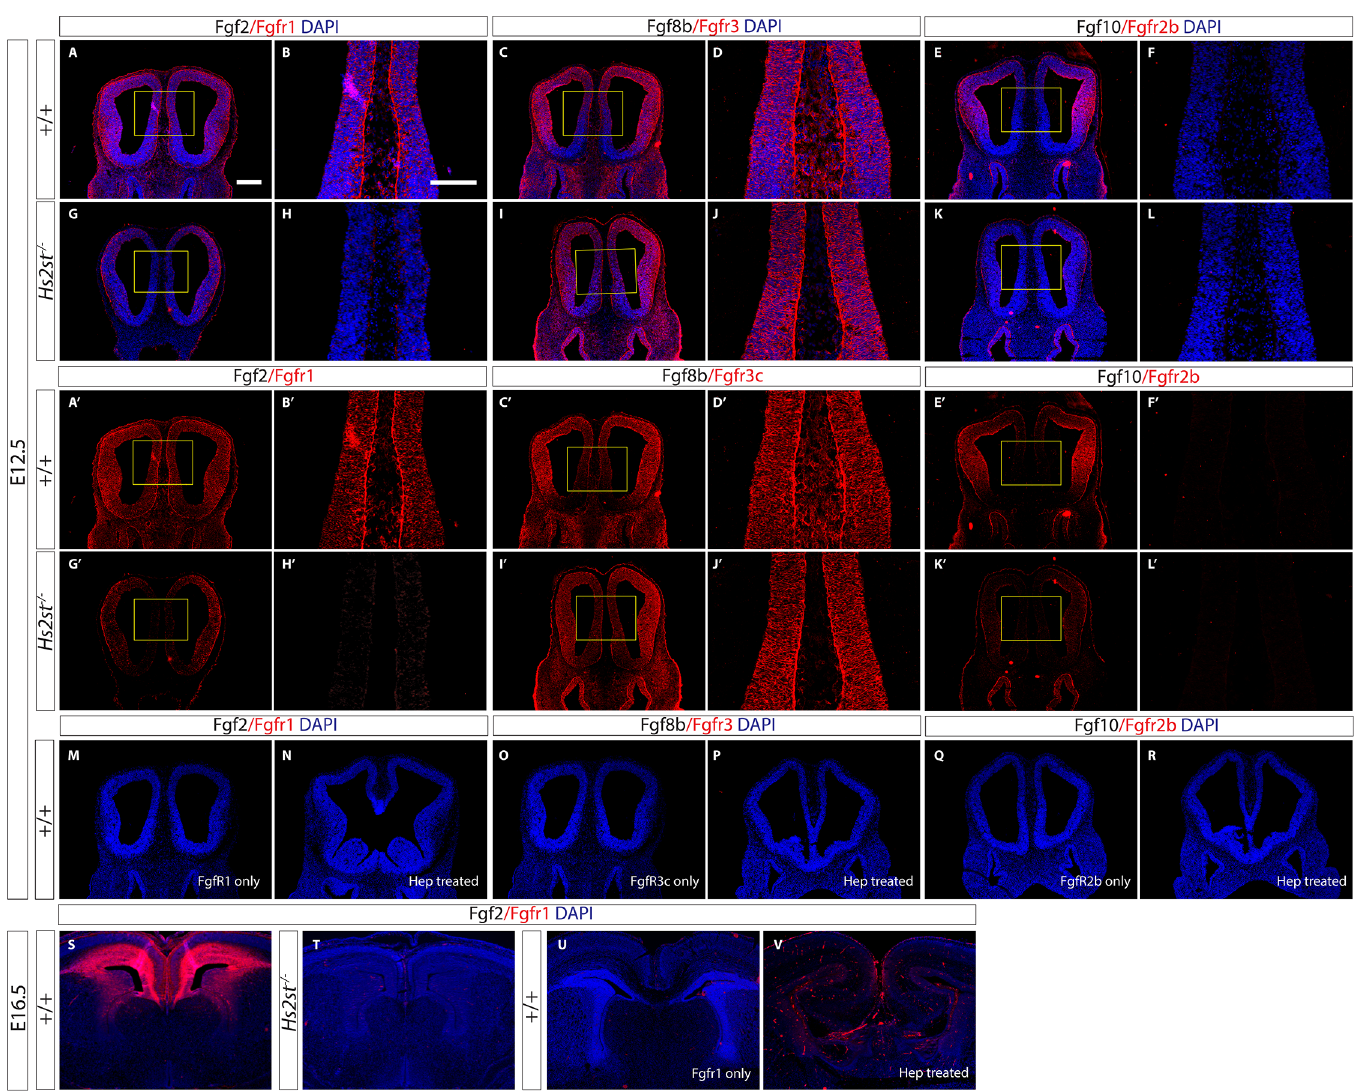
Fig 4. 2-O HS sulfation is specifically required for the formation of HS:Fgf2:Fgfr1 ternary complexes at the E12.5 rostral telencephalic midline. ( A-V ) LACE assay probing for the ability of several exogenously added Fgf:Fgfr pairs to form complexes with endogenous telencephalic HS where LACE signal reports formation of the HS:Fgf:Fgfr ternary structure. ( A-V ) show LACE signal (red) merged with nuclear counterstain DAPI (blue) and ( A ’ -L ’ ) show LACE signal (red) alone. ( A-R ) E12.5. ( A,B,G,H,A ’ B ’ G ’ H ’ ) HS:Fgf2:Fgfr1 LACE. ( A – B, A ’ – B ’ ) High Fgf2:Fgfr1 LACE signal throughout the wild- type telencephalon including the midline reporting formation of HS:Fgf2:Fgfr1 ternary structure. ( G – H, G ’ – H ’ ) Very low Fgf2:Fgfr1 LACE signal at the Hs2st -/- midline compared to wild-type while LACE signal persists more laterally indicating a loss of HS:Fgf2:Fgfr1 ternary structure formation specifically in the Hs2st -/- midline. ( C – D, C ’ – D ’ , I – J, I ’ – J ’ ) High HS:Fgf8b:Fgfr3 LACE signal throughout the telencephalon including the midline in both wild-type and Hs2st -/- telencephalon. ( E,F,K,L,E ’ ,F ’ ,K ’ ,L ’ ) HS:Fgf10:Fgfr2b LACE. ( E – F , E ’ – F ’ ) High HS:Fgf10:Fgfr2b LACE signal in the lateral wild-type telencephalon but not at the midline. ( K – L , K ’ – L ’ ) Low HS:Fgf10:Fgfr2b LACE signal throughout the Hs2st -/- telencephalon indicating a loss of HS:Fgf10:Fgfr2b ternary structure formation relative to wild-type in lateral Hs2st -/- telencephalon. ( B , D , F , H , J , L ) are higher magnification of yellow box in ( A , C , E , G , I , K ) respectively while ( B ’ , D ’ , F ’ , H ’ , J ’ , L ’ ) are higher magnification of yellow box in ( A ’ , C ’ , E ’ , G ’ , I ’ , K ’ ) respectively. ( S-V ) E16.5. ( S ) HS:Fgf2:Fgfr1 LACE signal in wild-type E16.5 telencephalon where high LACE signal was detected dorsally and laterally. (T) In contrast to the wild-type telencephalon, there is very little HS:Fgf2:Fgfr1 LACE signal detected in the Hs2st -/- telencephalon confirming that loss of 2-O HS sulfation disrupts the formation of the HS:Fgf2: Fgfr1 ternary structure at E16.5. Controls for the LACE assay where wild-type rostral telencephalon was reacted with Fgfr but without the respective Fgf ligand ( M, O, Q, U ) or pre-treated with Heparitinase I ( N, P, R, V ) respectively. There was no signal detected when Fgf ligand was omitted or HS was destroyed via Heparatinase I showing that the LACE assay signal reports the formation of the respective HS:Fgf:Fgfr ternary structure. Scale bars for ( C, E, G, I, K, A ’ , C ’ , E ’ , G ’ , I ’ , K ’ , M – V ) are represented in ( A ) where it is 250 μ m and ( D, F, H, J, L, B ’ , D ’ , F ’ , H ’ , J ’ , L ’ ) are represented in ( B) where it is 150 μ